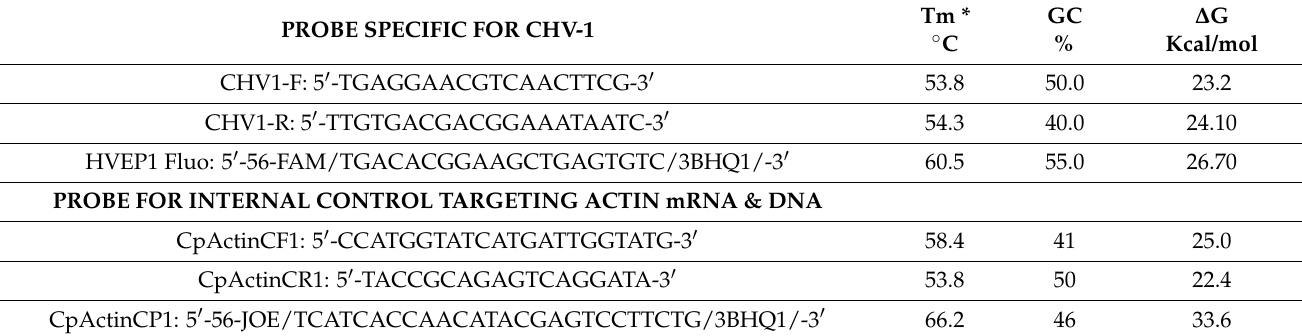
Table 2. Oligonucleotides and fluorescent TaqMan probes used in this study for the real-time detection of the CHV-1